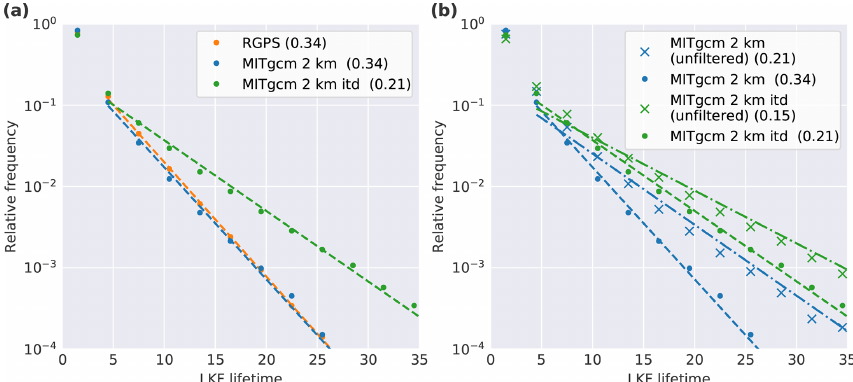
Figure 10. (a) The relative frequency of lifetime of LKFs in RGPS data and both simulations. The LKFs detected and tracked in the simulations are reduced to the RGPS coverage. The dashed line are fits to exponential tails. The rate of the exponential tail in d − 1 is given in the legend. (b) Lifetime of modeled LKFs reduced to the RGPS coverage (dots and dashed lines) and unfiltered (crosses and dot-dashed lines).